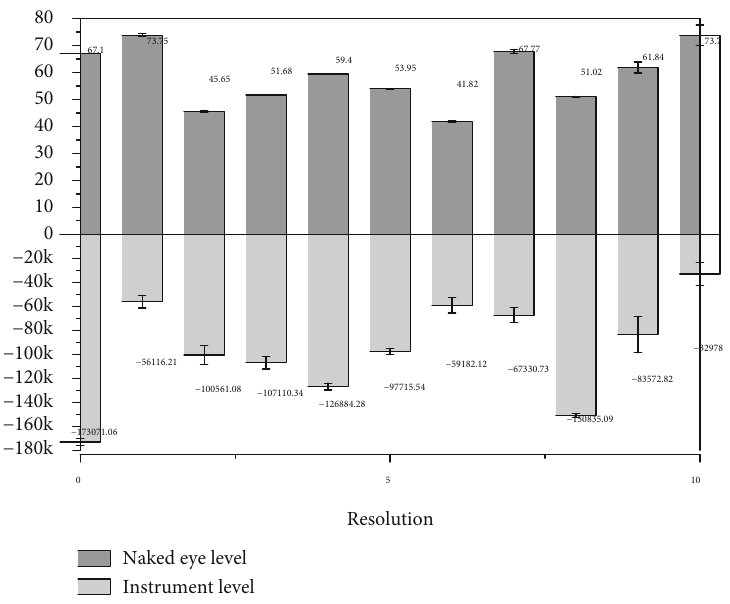
Figure 7: The human eye ’ s ability to discriminate between